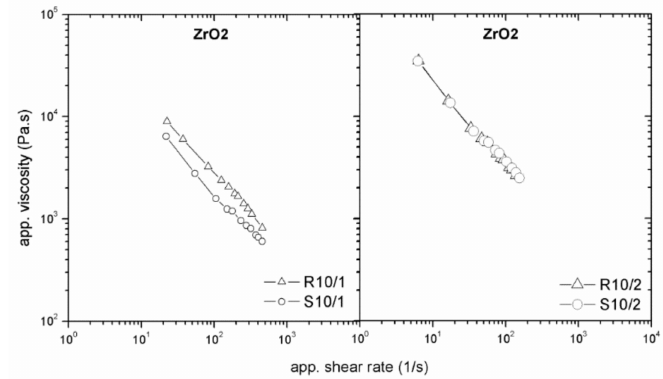
Figure 8. Effect of die dimension on the flow properties of zirconium oxide (ZrO 2 )/LDPE+EVA+PW feedstock.